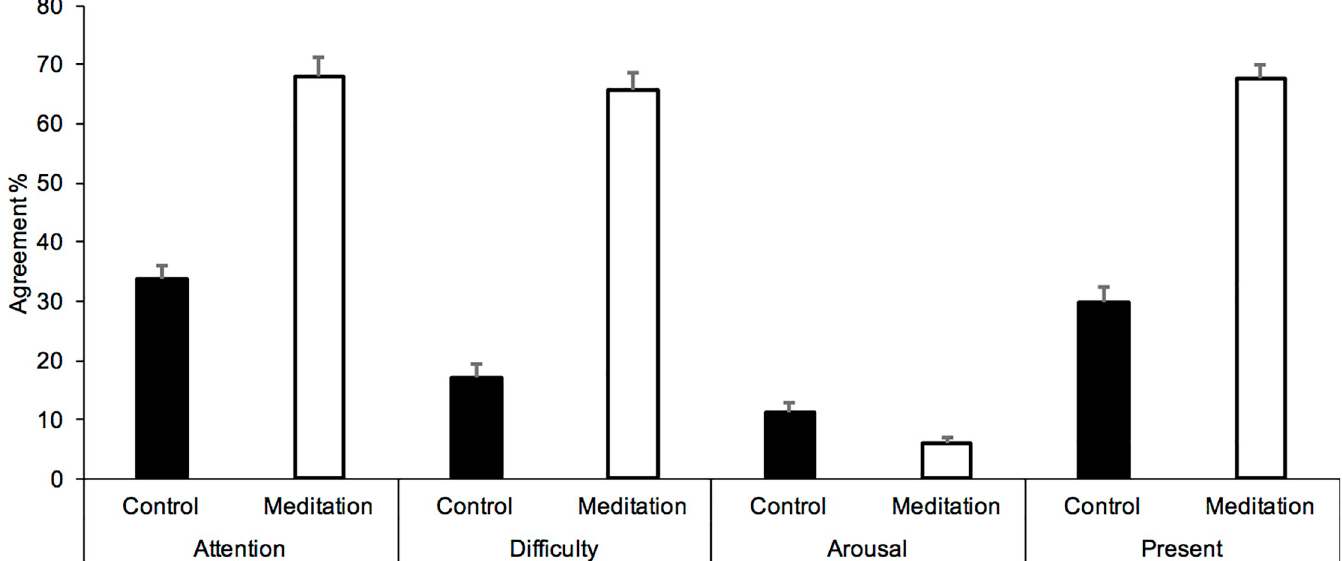
Fig 4. Judgment scores. Mean ( SE ) percentage of agreement for attentional demand, task difficulty, arousal and focus on the present moment in the meditation and the control condition.